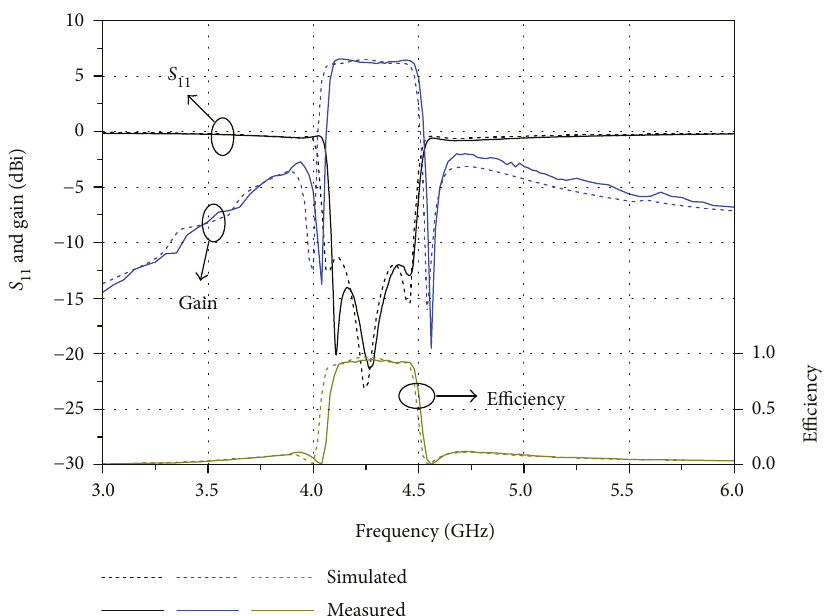
Figure 11: Simulated (dashed lines) and measured (solid lines) re fl ection coe ffi cient S